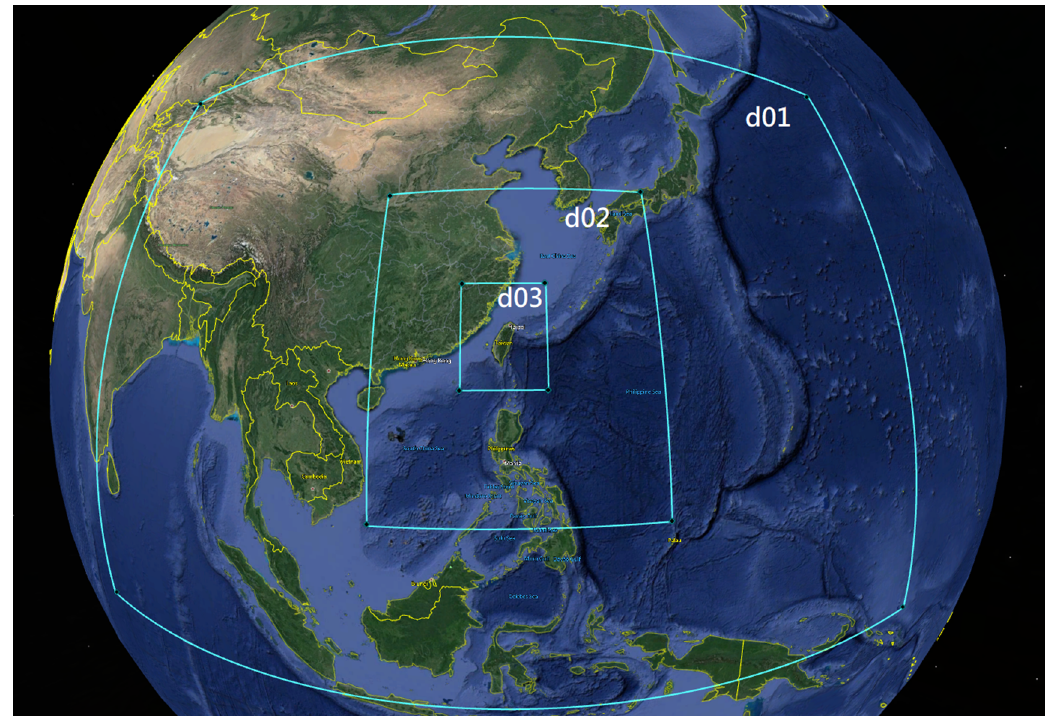
Figure 3. The Weather Research and Forecasting (WRF) model domain configuration with three nested domains. The parent domain (d01), domain 2 (d02), and domain 3 (d03) have horizontal grid resolutions of 45, 15, and 5 km, respectively.